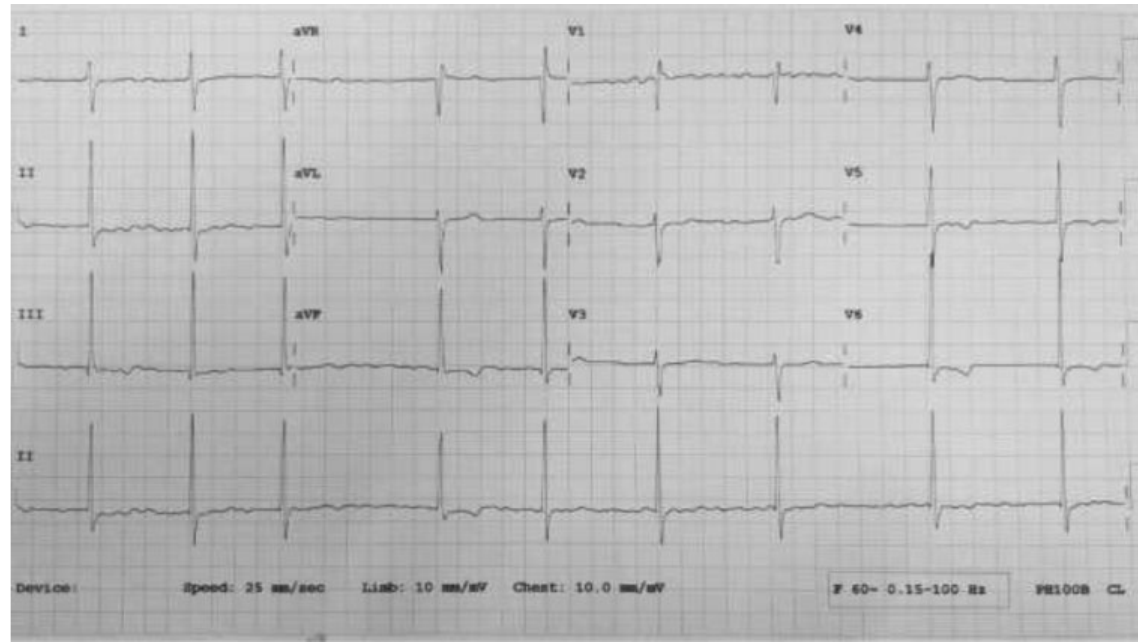
Fig. 1 Electrocardiogram on presentation after chest